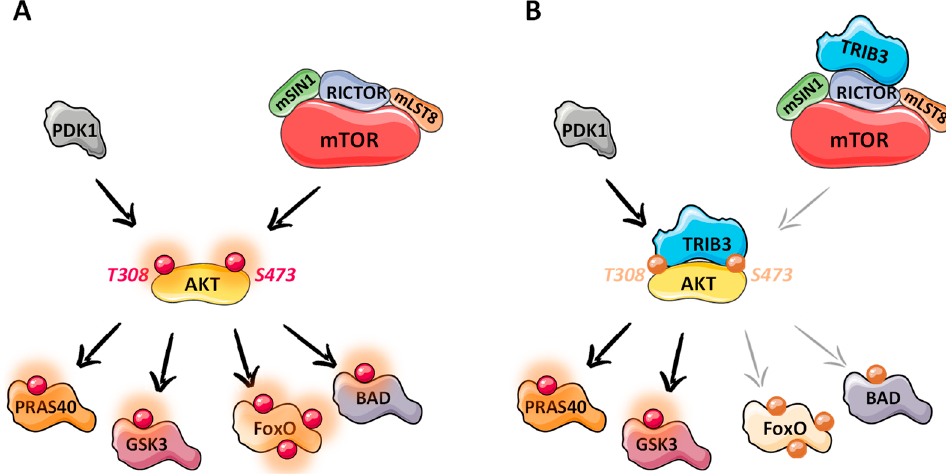
Figure 6. Putative mechanisms of TRIB3-mediated AKT signaling inhibition. Red circle = phosphorylation. (A) Activated signaling pathway in absence of TRIB3. (B) Partial inhibition of the signaling pathway in the presence of TRIB3.